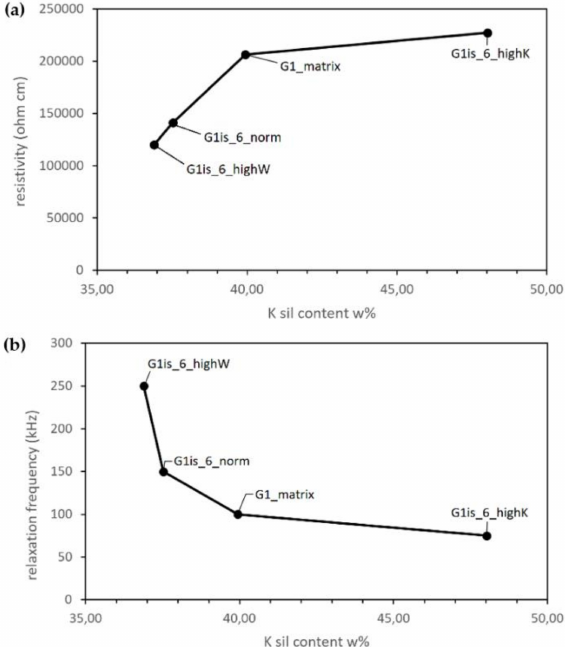
Figure 18. Bulk resistivity ( a ) and relaxation frequency ( b ) vs. Ksil content expressed in weight% with respect to the initial